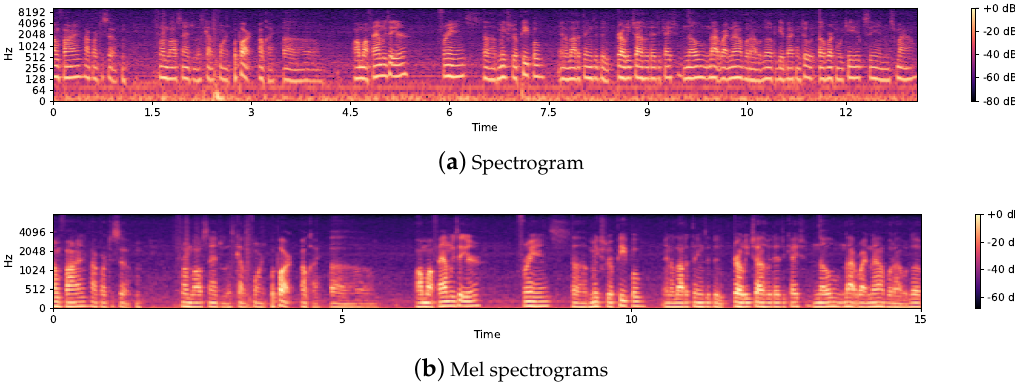
Figure 2. An example of ( a ) spectrogram and ( b ) Mel spectrogram features generated from a clip of